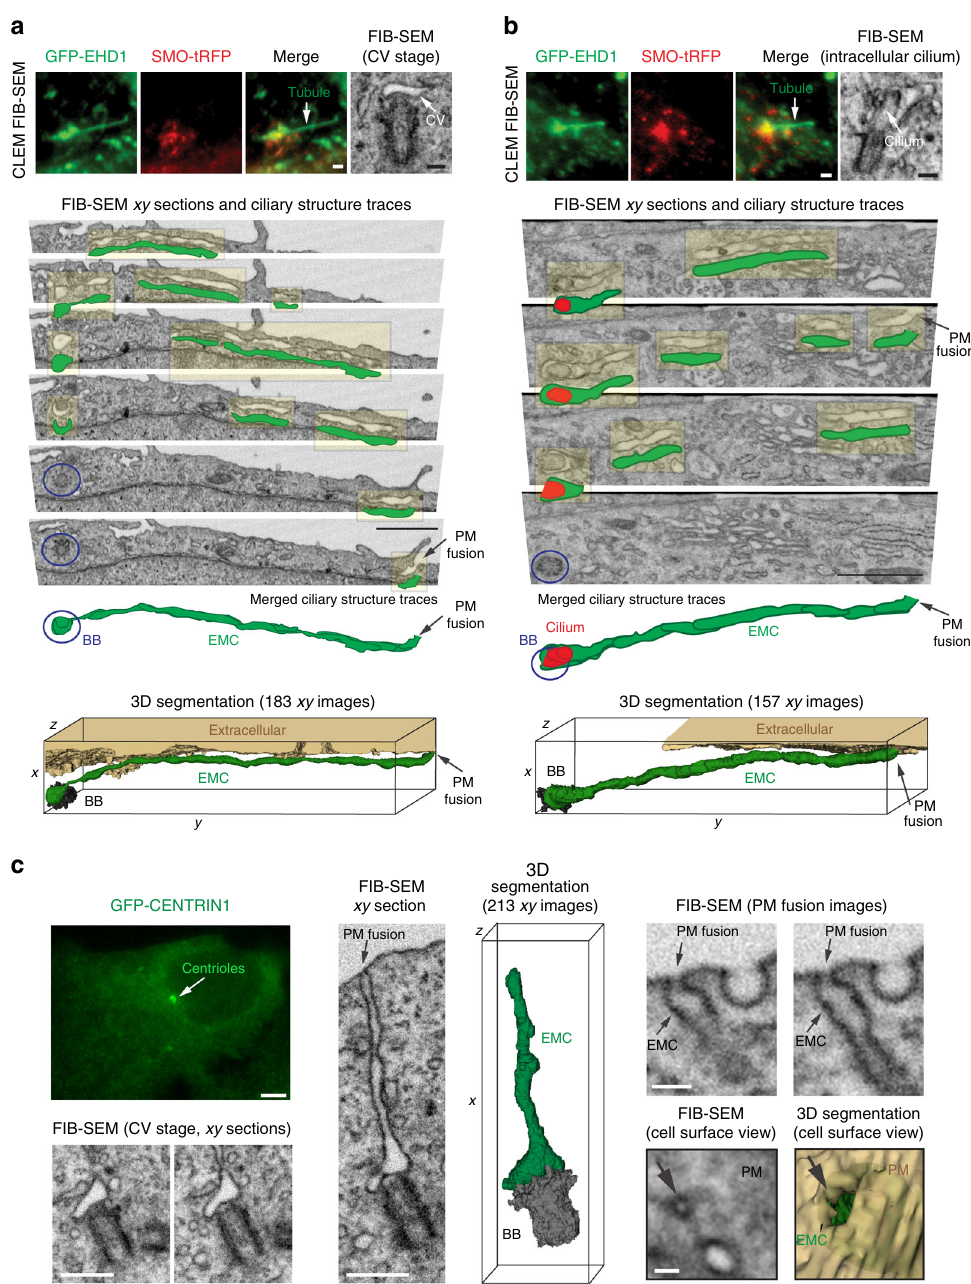
Fig. 7 Membrane tubules connect the CV/developing cilium and the PM creating an extracellular membrane channel. a , b CLEM/FIB-SEM analysis of a 3 h starved GFP-EHD1 + SMO-tRFP cell showing a CV ( a ) and a short intracellular cilium ( b ) connected to GFP-EHD1-positive tubular membranes. Fluorescence images (upper left and middle panels, scale bar: 1 μ m) and longitudinal FIB-SEM section of the BB/cilium (upper right panel, scale bar: 200 nm). Below are representative FIB-SEM xy image sections (183 sections in a and 157 sections in b ) showing a continuous membrane tubule connecting the CV and short intracellular cilium to the PM, respectively (Scale bar: 1 μ m). Blue circles highlight the BB region. Traces for the extracellular membrane channel (EMC) connected to the CV ( a ) or short intracellular cilium ( b ) are shown in green offset from FIB-SEM EMC structures (highlighted in yellow). The cilium outline is traced in red. Merged ciliary structure traces and 3D segmentation of the CV and short intracellular cilium and the EMC connected to the PM from the xy FIB-SEM images are shown in the last two lower panels. The raw FIB-SEM images for a can be found in Supplemental Movie 3 and b in Supplemental Movie 4. c CLEM/FIB-SEM of 3 h starved GFP-CENTRIN1 cell ( fl uorescence images in upper left panel, scale bar: 2 μ m). Representative FIB- SEM images (213 xy images) (bottom left and middle left panels, scale bars: 500 nm) and 3D segmentation (middle right panel) showing an EMC connecting the CV and the PM. FIB-SEM images (right panels, scale bar: 100 nm) showing different cross-sections of the EMC connected to the plasma membrane (PM) (top right panels). A view of the cell surface showing the EMC opening at the PM (arrow) and the 3D segmentation of the EMC opening (green) at the PM (bottom right panels). A summary of CLEM FIB-SEM data sets is shown in Supplementary Table